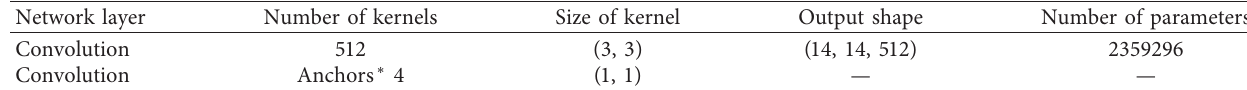
Table 2: The composition and parameter setup of regression network.